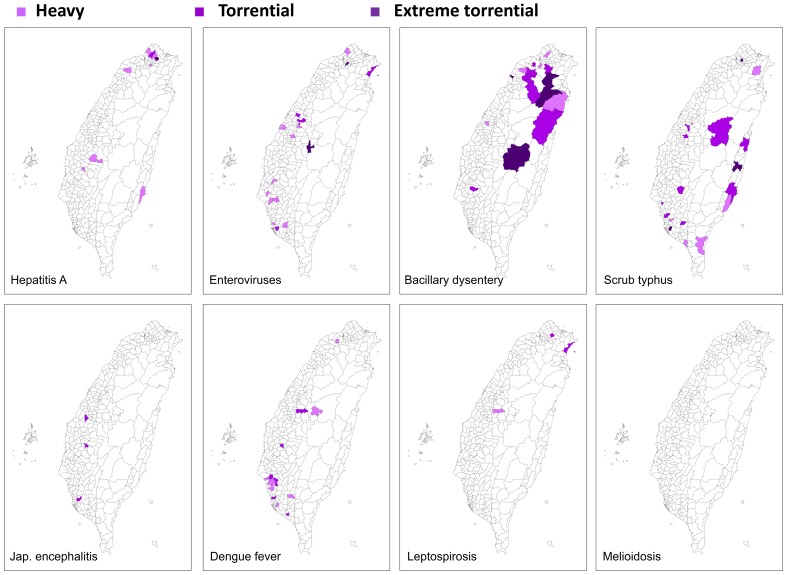
Risk maps of the 8 climate-related infectious diseases following extreme precipitation events were generated when the analysis was integrated with the GIS system.The townships that had a significant association between the outbreak of the specified disease with the category of extreme precipitation events are marked on each map. Townships that had significant associations with heavy precipitation are marked in light purple, with torrential precipitation are marked in purple, while those that only had significant associations with extreme torrential precipitation are marked in dark purple.